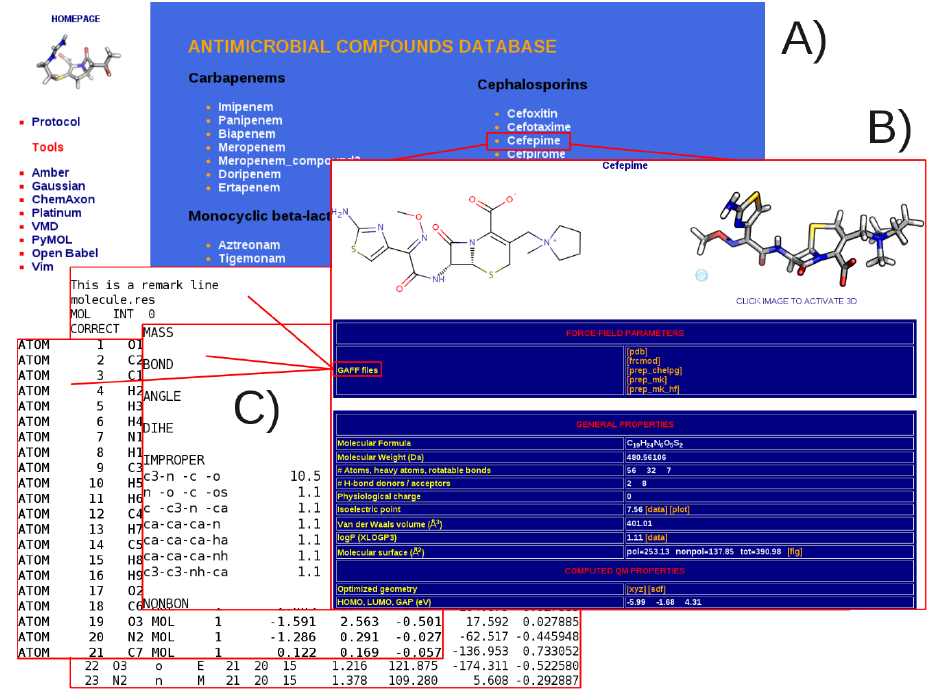
Figure 2. Snapshots of the main page of the database ( A ); an individual page ( B ); and the General Amber Force Field parameters files downloadable for each compound ( C